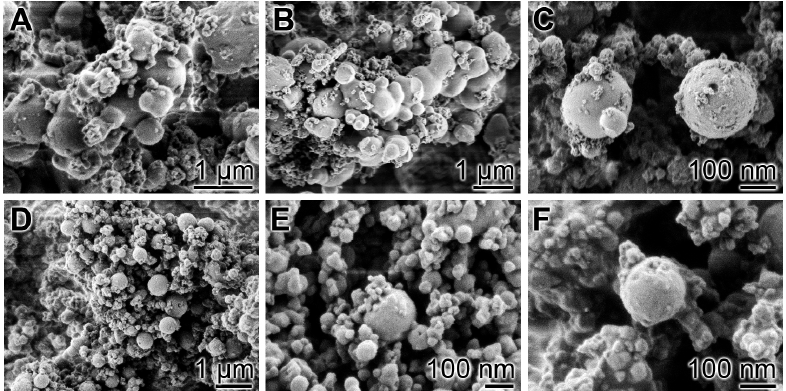
Figure 3. Morphology of “Ca–polyP-MPs” and “Mg–polyP-MPs”; SEM analysis. ( A, B, C ) “Ca–polyP-MP” and ( D , E , F ) “Mg–polyP-MP”.